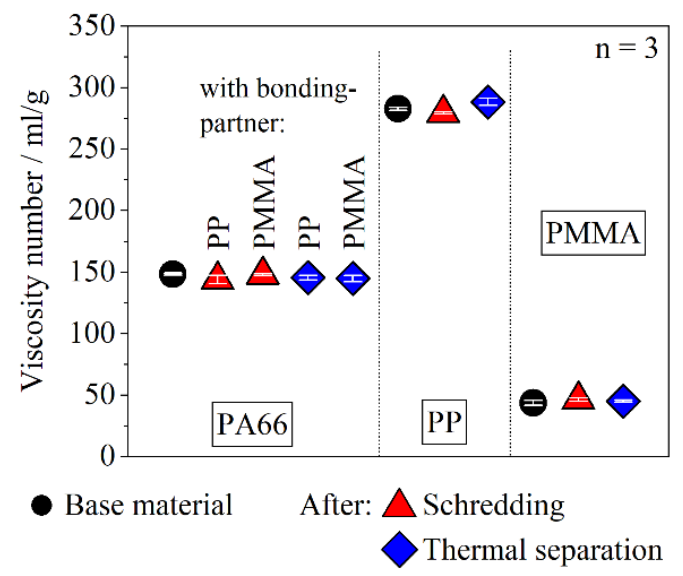
Figure 9. Material degradation after separation of the multi ‐ material